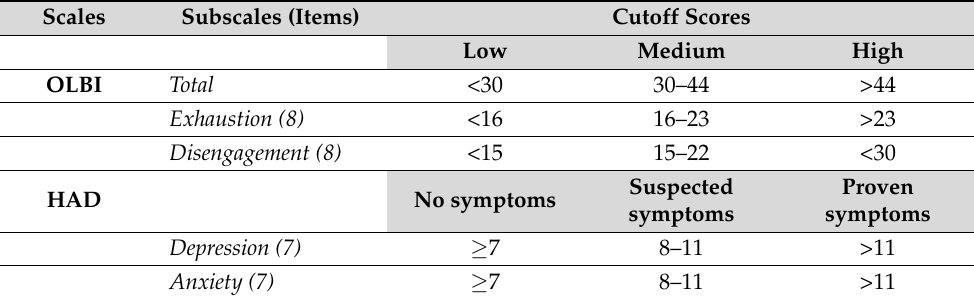
Table 1. Cut-off scores to interpret results for the Oldenburg Burnout Inventory (OLBI) and Hospital Anxiety Depression